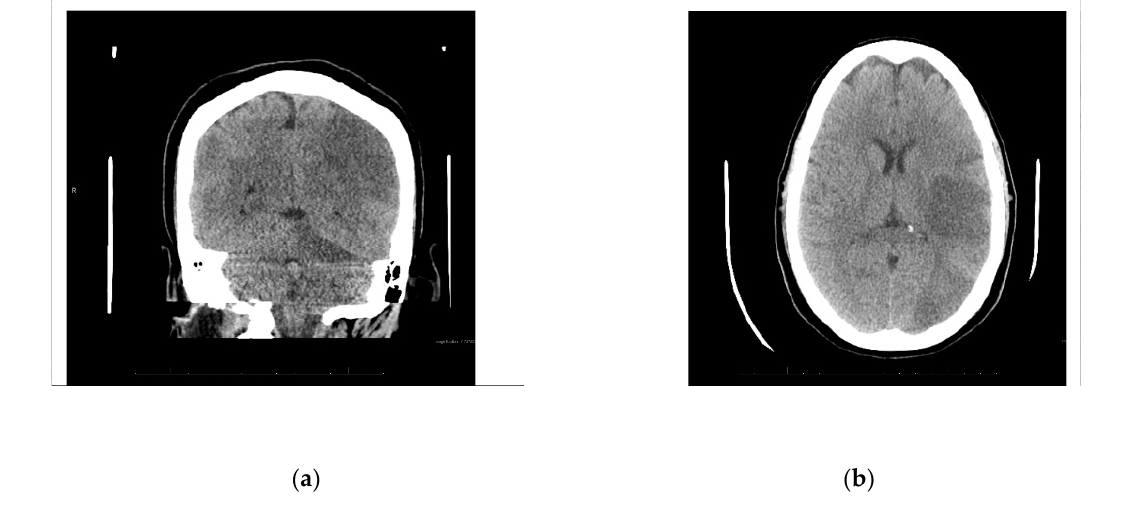
Figure 2. ( a ) Di ff use infarcts; ( b ) Temporal and occipital lobe Figure 2. ( a ) Diffuse infarcts; ( b ) Temporal and occipital lobe infarcts.